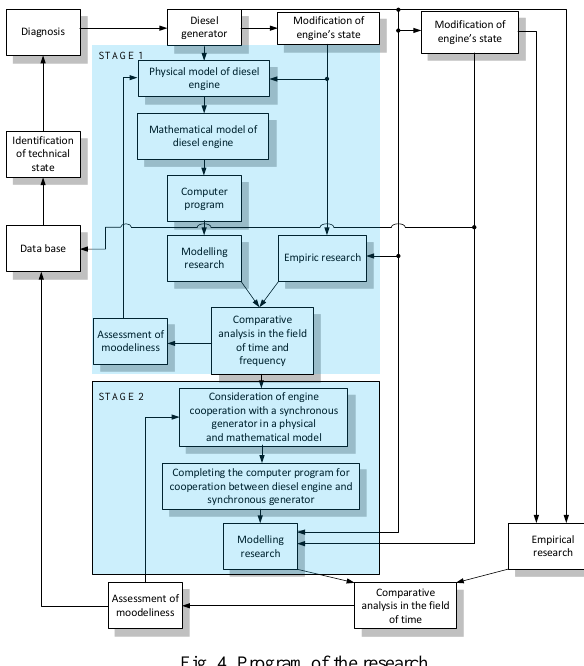
Fig. 4. Program of the